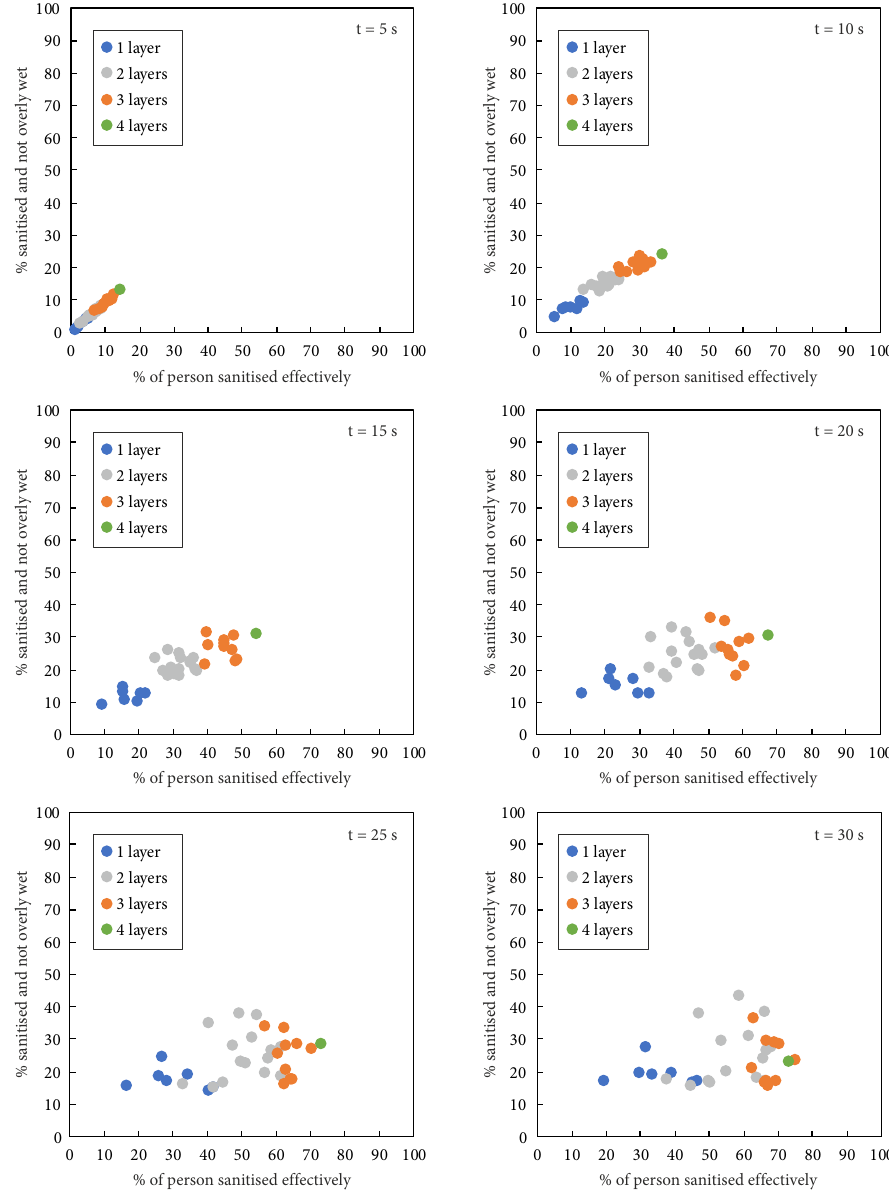
Figure 10. Performance of chamber for various nozzle layouts. Results shown are for mediumweight clothing